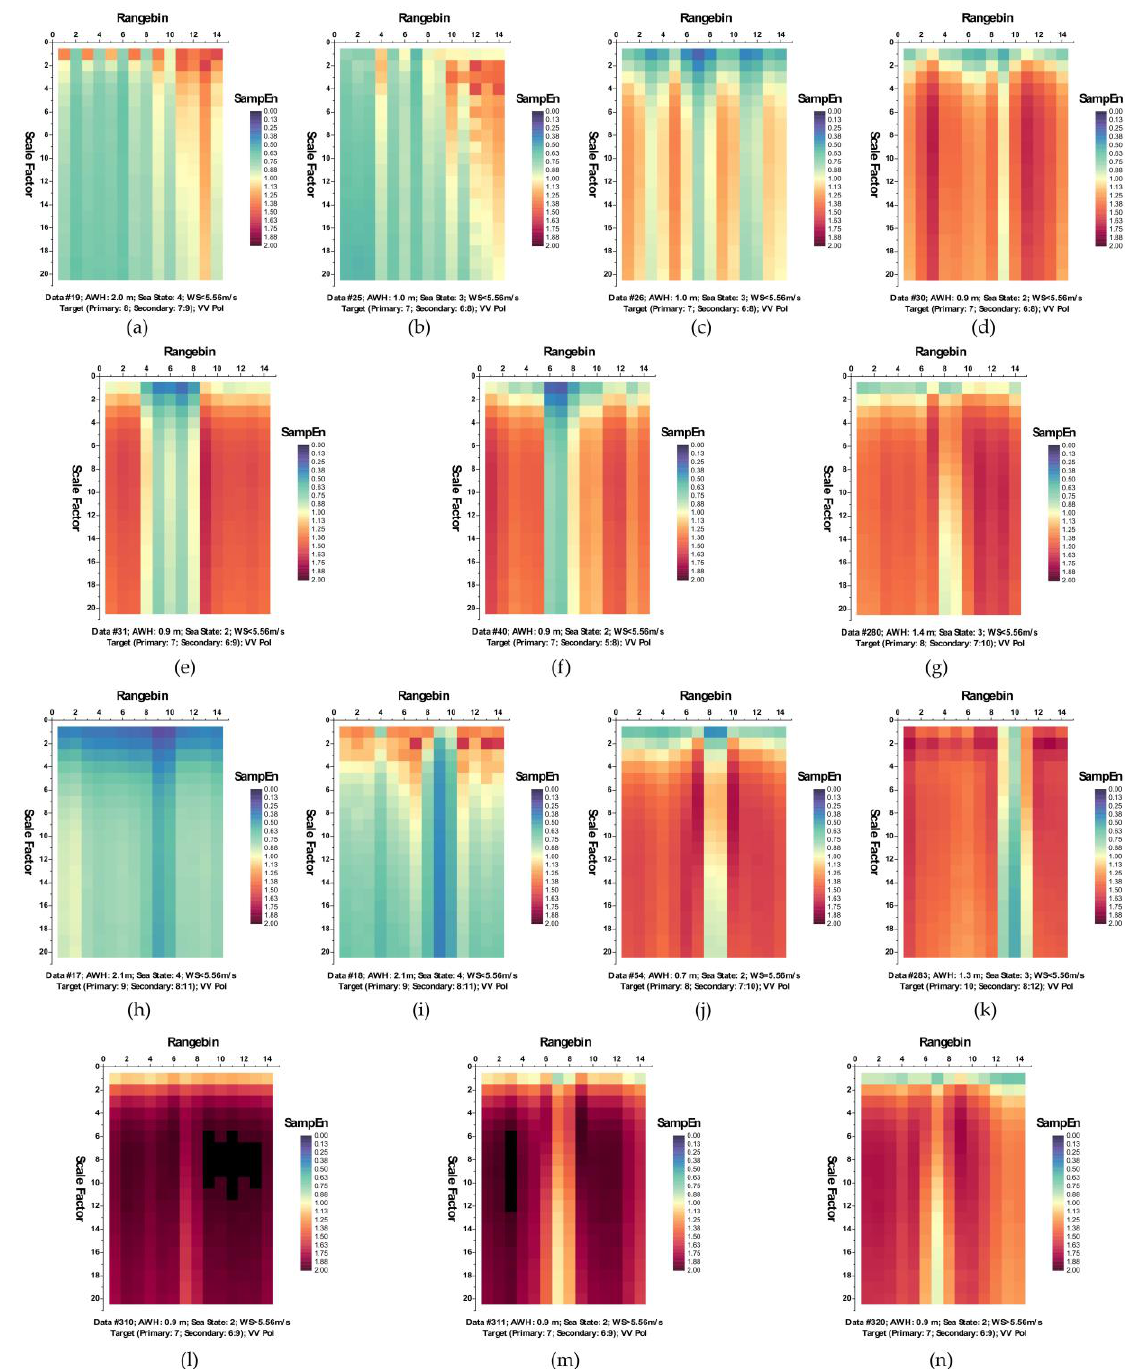
Figure 7. ( a – n ) MSE of 14 sea clutter data sets (VV polarization, m = 2, τ = 20, r = 0.15 ∗ std { s } ). It is observed from Figure 6 that at wave heights larger than 2.0 m (data sets 17 and 18) or at wind speeds equal to or higher than 5.56 m/s (data sets 56, 310, 311, and 320), the MSE of range bins with the primary target can be easily distinguished from that of range bins in sea clutter by (i) the estimated SampEn at large scale factors, for instance, at scale factor τ = 10, and (ii) the CI introduced in Section 3.2.1 since the MSE of range bins with the primary target is smaller than that of range bins in sea clutter. Meanwhile, within the same data sets, the same performances can be observed from Figure 7 for VV polarization. From Figures 8 and 9, we see that the CIs are effective under high sea